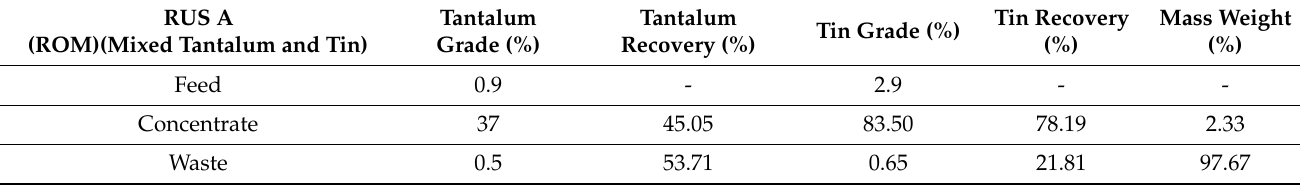
Table 2. RUS A mechanized processing results.